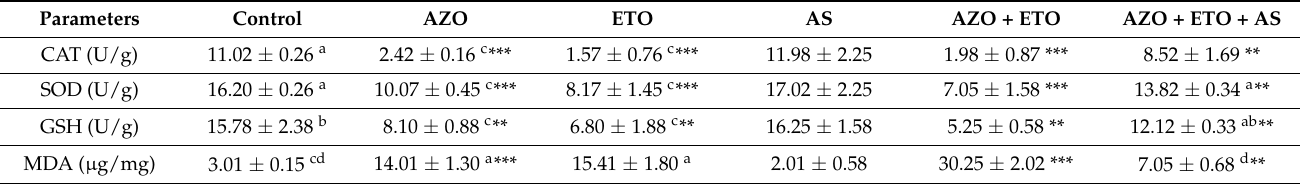
Table 4. Effects of ascorbic acid on oxidative stress enzymes and oxidative damage markers in hepatic tissues in male rats after administration of either azithromycin or etoricoxib or their combinations after 30 days post